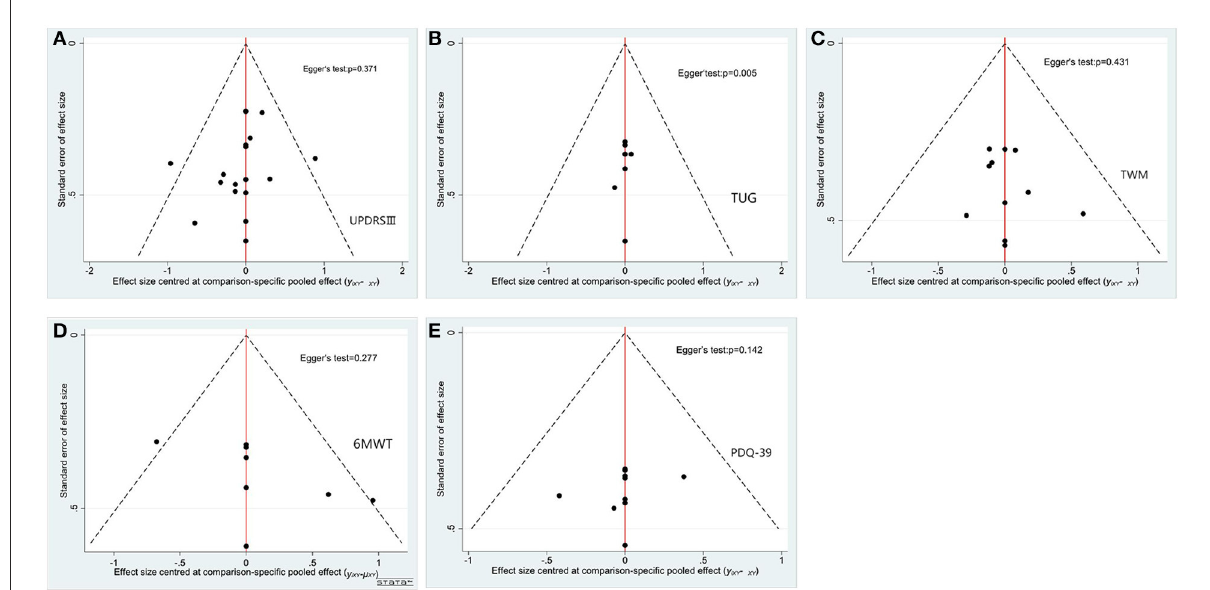
FIGURE7 Funnel plots and bias of aerobic and resistance exercise outcomes [ (A) UPDRS-III outcome; (B) TUG outcome; (C) TWM outcome; (D) 6MWT outcome; (E) PDQ-39 outcome; SP-MI-AE, short period moderate intensity aerobic exercise; SP-LI-AE, short period low intensity aerobic exercise; SP-HI-RT, short period high intensity resistance training; SP-HI-AE, short period high intensity aerobic exercise; SP-LI-RT, short period low intensity resistance training; LP-LI-AE, long period low intensity aerobic exercise; LP-HI-RT, long period high intensity resistance training; LP-HI-AE, long period high intensity aerobic exercise; LP-MI-AE, long period moderate intensity aerobic